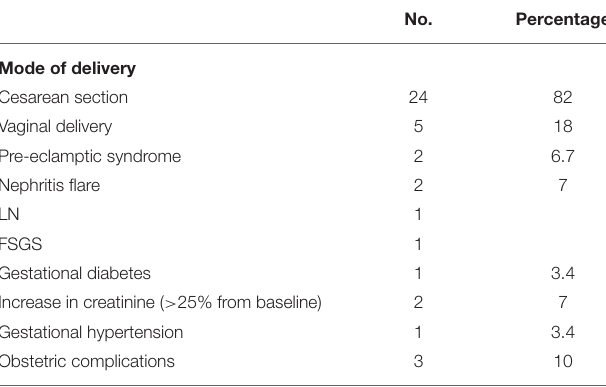
TABLE 6 | Maternal outcomes.